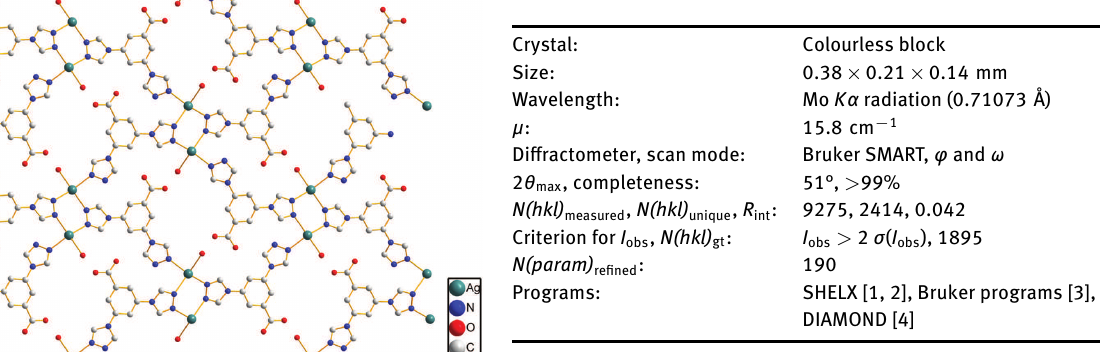
Table 1: Data collection and